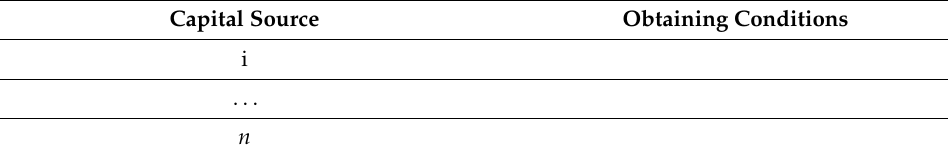
Table 2. List and conditions for obtaining capital that can be used to finance a project. Source: designed by